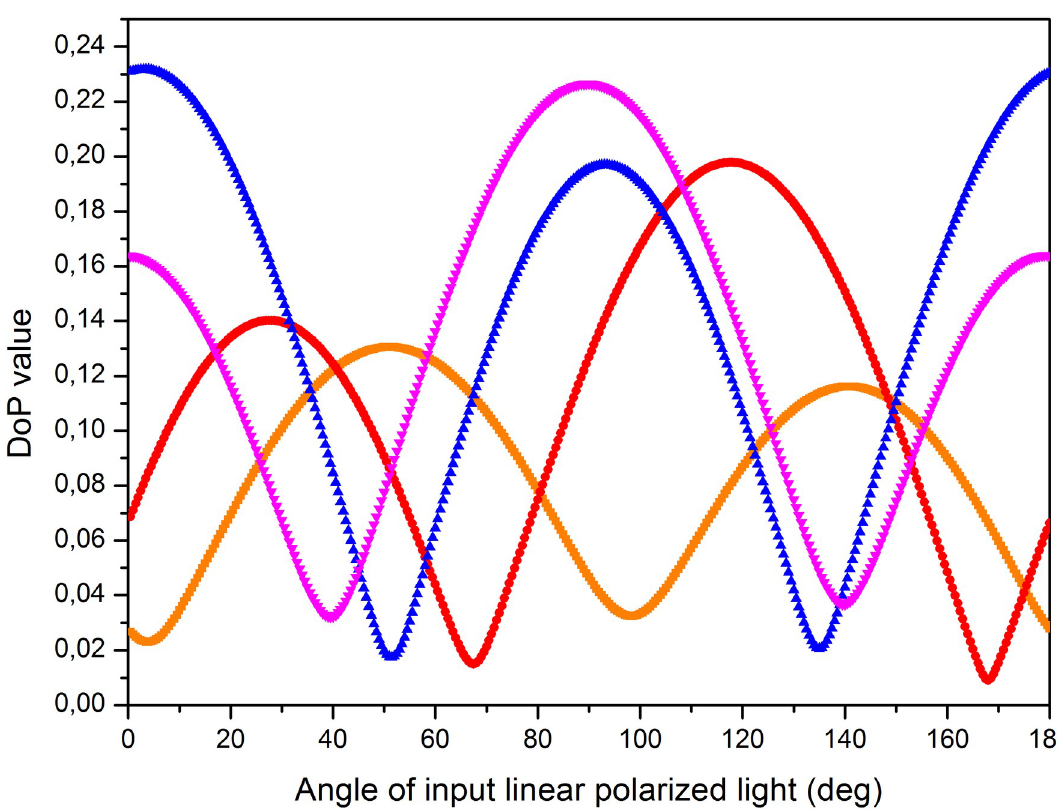
Fig 5. DoP values as a function of the input linear polarization orientations. Orange (squared), red (circle), blue (triangle) and purple (inverted triangle) curves correspond to the segments of the same color in Fig 3A.